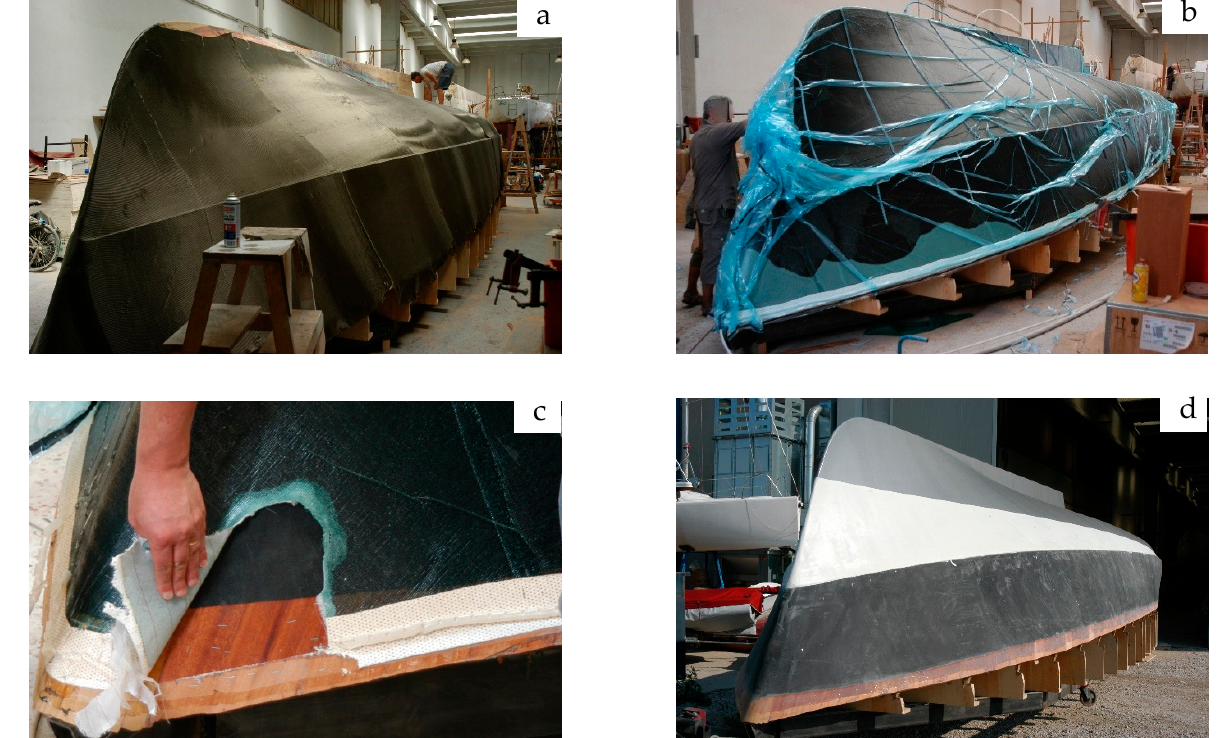
Figure 2. External gel-coating of the hull.